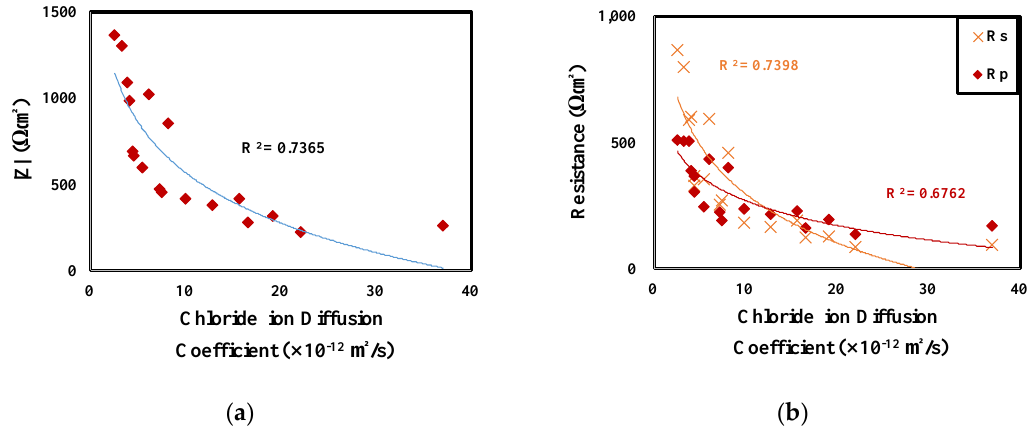
Figure 11. Relationship between impedance and chloride ion diffusion coefficient. ( a ) |Z| (Z total ), ( b ) R s (Z min ) and R p (Z max − Z min ).